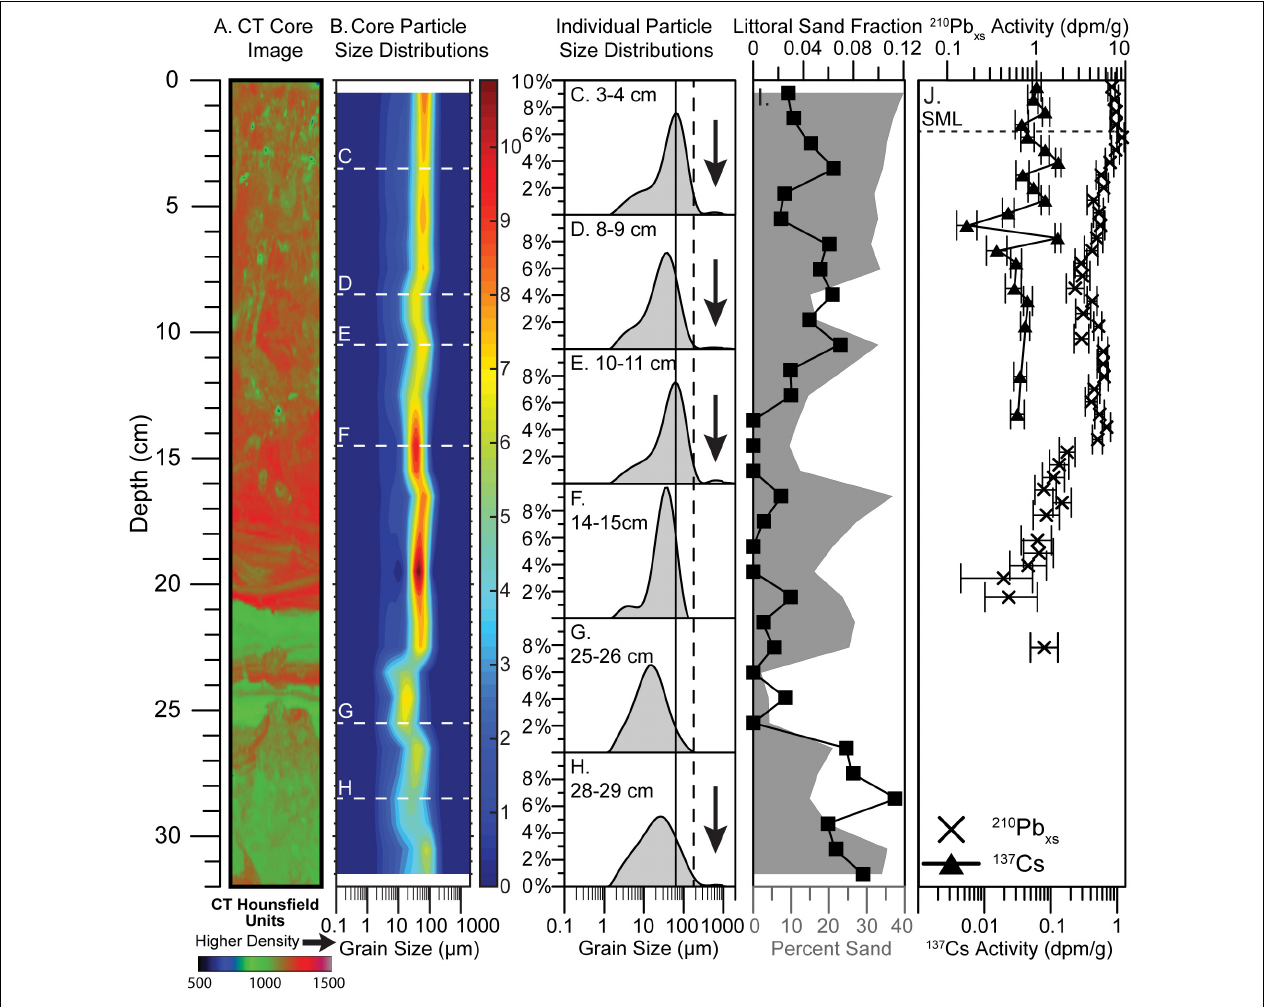
FIGURE 5 | Results from PS1410-11MC (see Figure 1 for location). (A) CT image of the core where cooler colors (blues and greens) are relatively lower density deposits, and warmer colors (reds) are higher density. (B) Down core total grain size distribution for all samples. In this plot the y-axis is depth down the core, x-axis is particle size, and the colors represent the volume present of the sample that fall within those size classifications, where warmer colors are higher percentages and cooler colors are lower percentages. The warmest color region across any depth horizon represents the mode for the sample. Representative individual sample particle size distributions (PSD) are shown in (C–H) , where the depths of these PSD are highlighted in (B) as white dashed lines. The solid black vertical line in (C–H) notes the silt/sand boundary at 63 µ m and the dashed black vertical line notes the Monterey Bay littoral cutoff diameter at 180 µ m (see text for explanation). Black arrows in the plot point to samples with increases in material coarser than the littoral cutoff diameter. The raw measurement size bins for the instrument were used to create the distributions in (B–H) . (I) Down core results from the grain size analysis with total percent sand (gray area) and the littoral sand fraction (black squares – see text for explanation). (J) Down core results for the 210 Pb xs (black Xs) and 137 Cs (black triangles). The dashed horizontal line is the inferred depth of the Surface Mixed Layer (SML) based on the 210 Pb xs